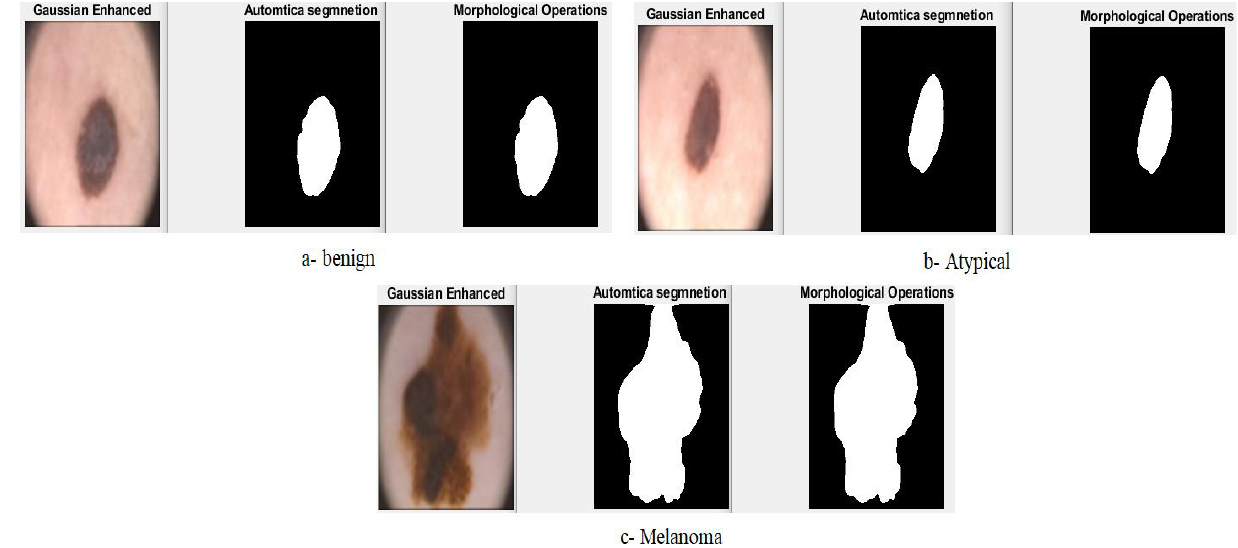
Figure 6. Enhancement and segmentation process for some images from the PH2 dataset.